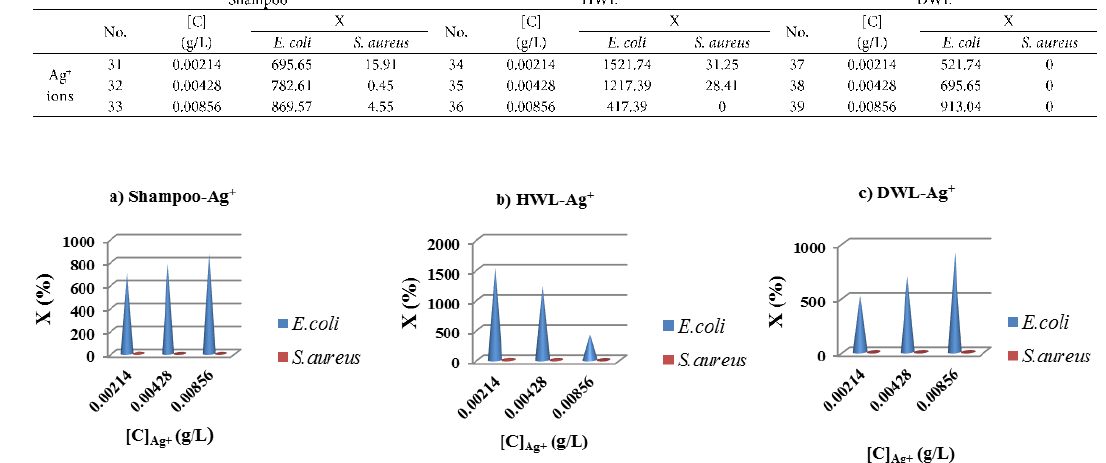
Fig. 2. Percentage growth of bacteria vs. concentration of silver ions released from silver nanoparticles (Ag NPs) a) shampoo, b) HWL, and c) DWL samples